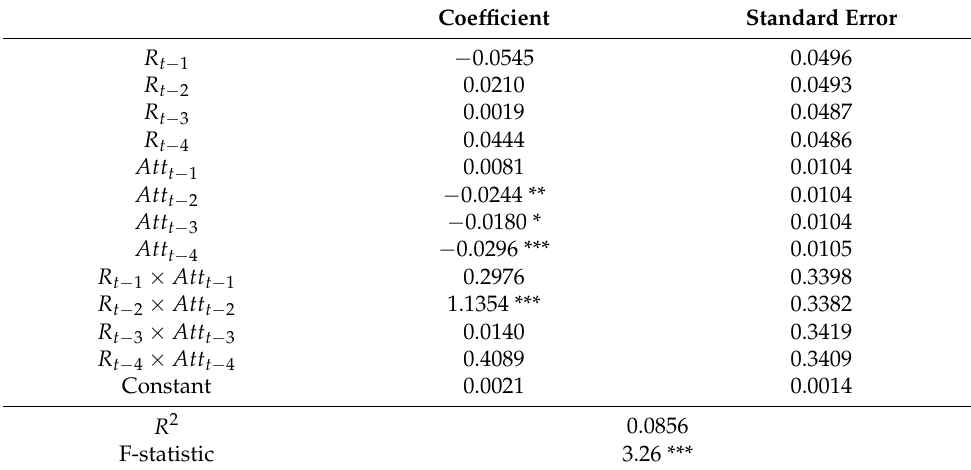
Table 5. Estimation of Equation (4).